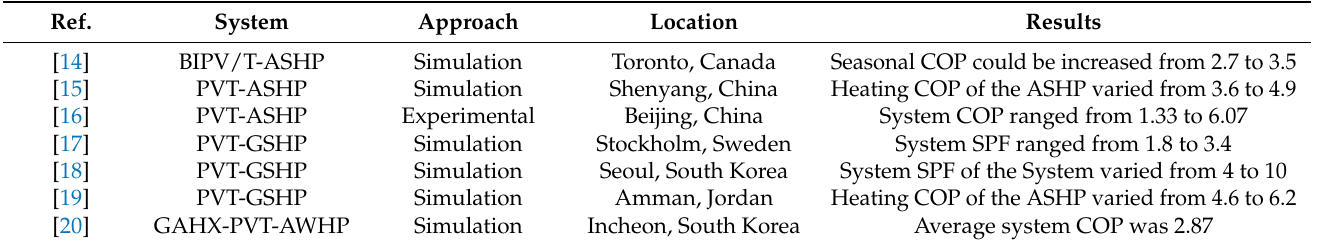
Table 1. Summary of the previous studies analytical approach method and results.